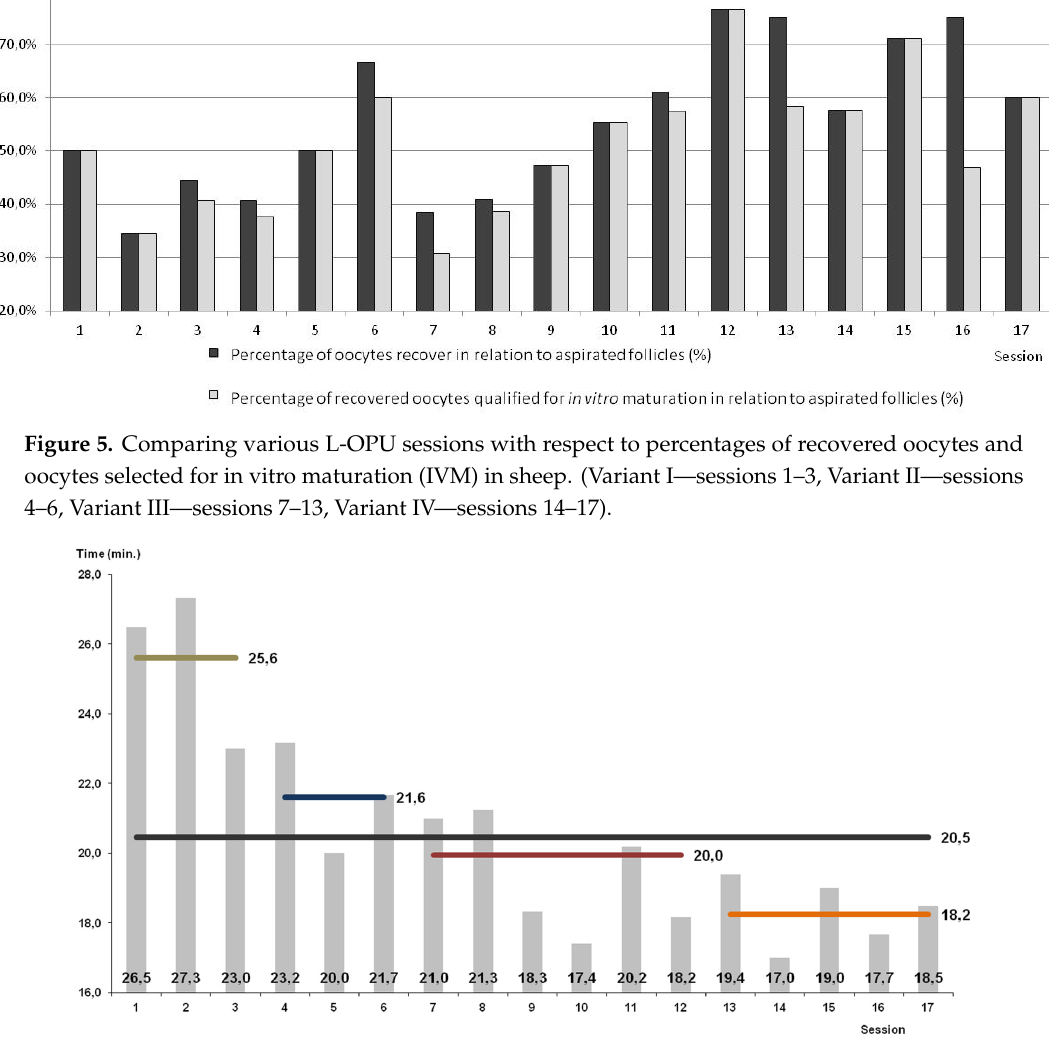
Figure 6. Timing of the L-OPU procedure in goats.